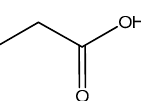
Figure 1. Gamma ‐ aminobutyric acid